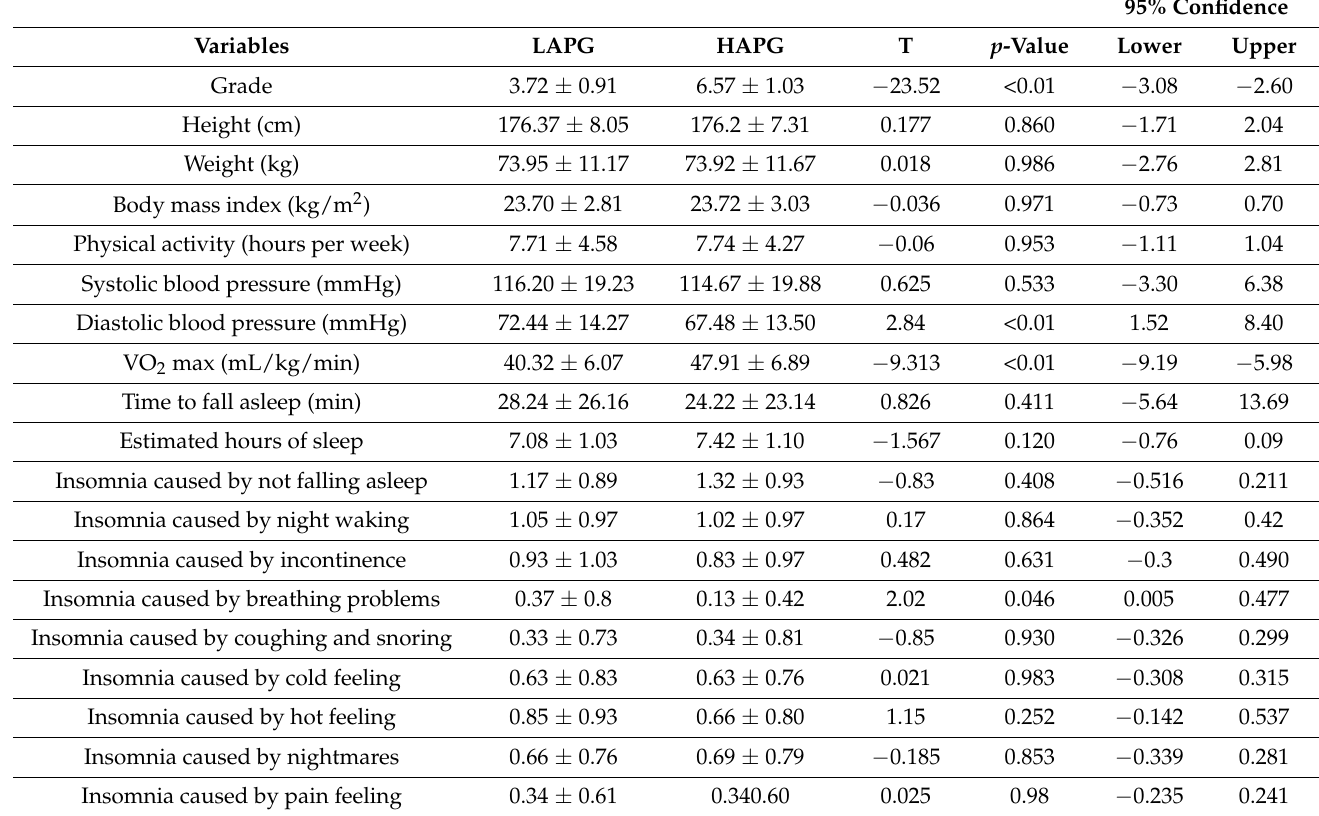
Table 1. Anthropometric and physiological variables and physical activity and sleep habits differences between low academic performance group (LAPG) and high academic performance group